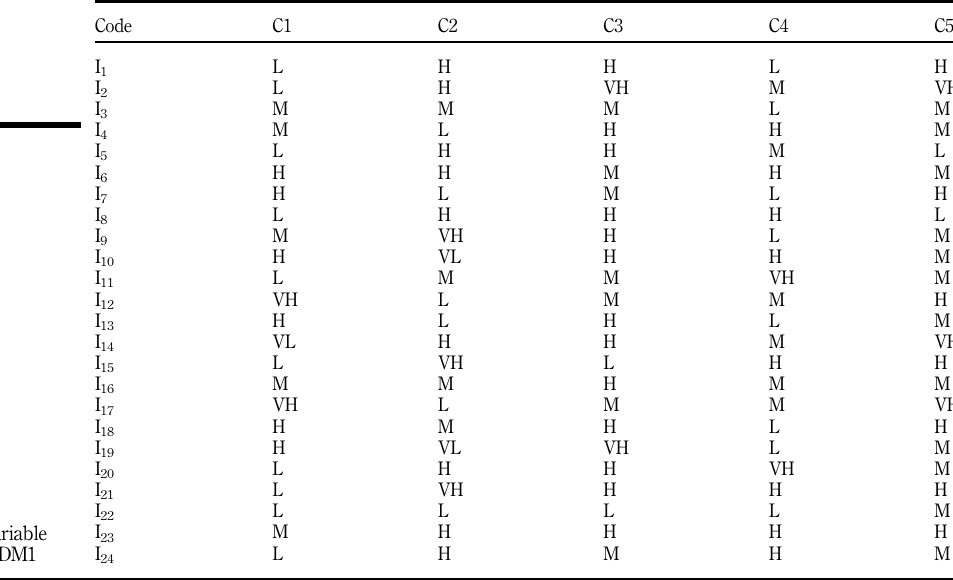
Table A1. Linguistic variable assigned by DM1